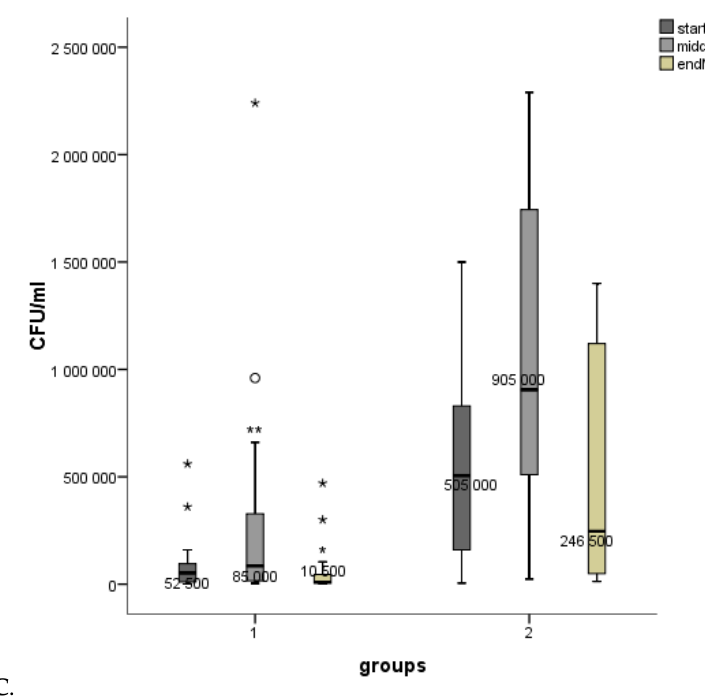
Figure 1. Boxplots for mean microbial counts (CFU/mL), ( A ). Candida (SAB), ( B ). S. mutans (MITIS) and ( C ). Lactobacilli (MRS). Measuring points for group 1 (start = 0 days, middle = 14 days, end = 28 days) and group 2 (start = 0 days, middle = 7 days, end = 14 days). p < 0,001***, p < 0,01**, p < 0,05* (smaller asterisks). Decreases/increases of microbial counts were compared pairwise: start/middle, start/end. Values more than three interquartile range (IQR) from the end of a box are labeled as extreme outliers (larger asterisks) and values more than 1.5 but less than 3 IQR’s from the end of a box are labeled (o) outliers.